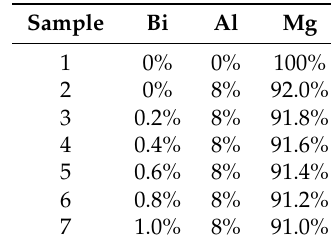
Table 1. Sample content of Mg–Al–Bi alloys.